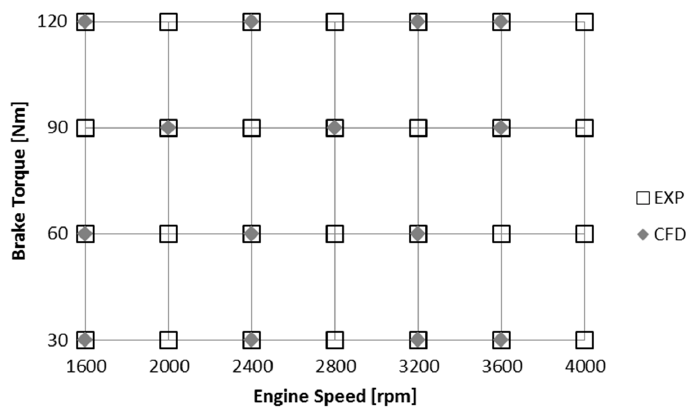
Figure 2. Experimental and CFD test conditions.